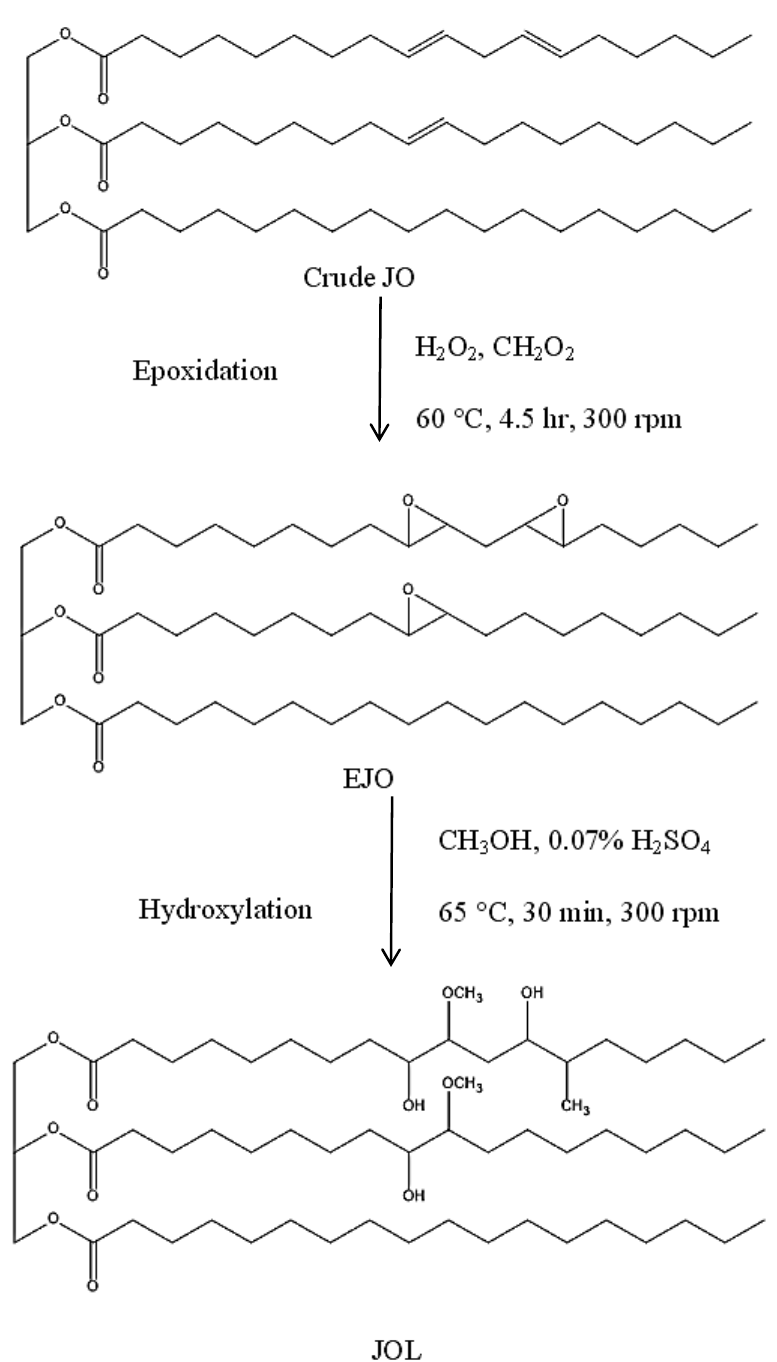
Figure 2. Proposed chemical reactions to produce jatropha oil-based polyol (JOL).